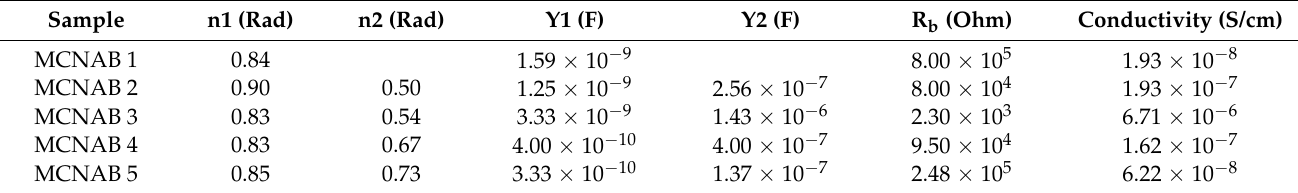
Table 2. The parameters of the circuit elements of the films at room